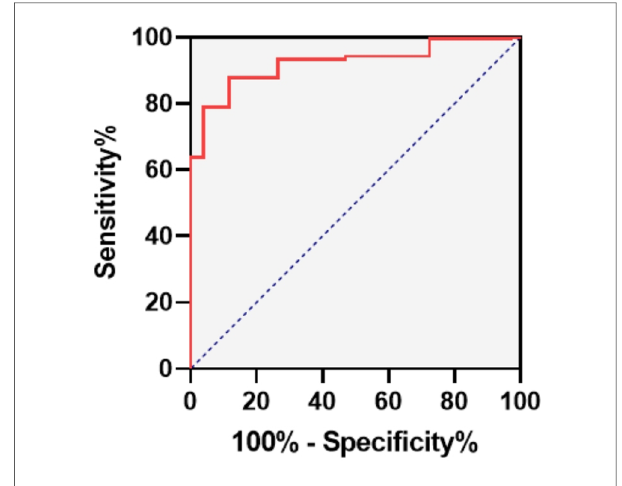
FIGURE 1 The receiver operating characteristic curve of EGSYS